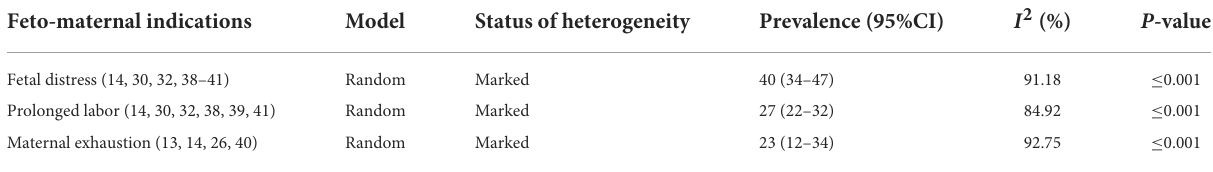
TABLE 4 Feto-Maternal indications for operative vaginal deliveries among women who gave births in Ethiopia, 2022. Feto-maternal indications